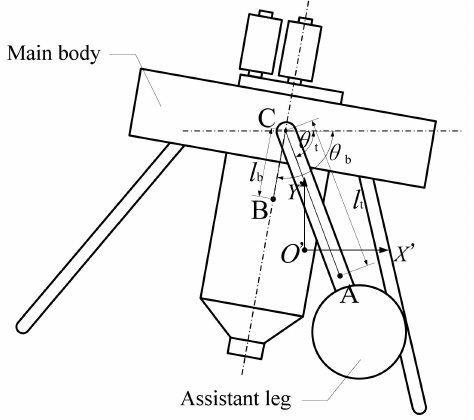
Figure 5. The schematic diagram of jumping robot in the